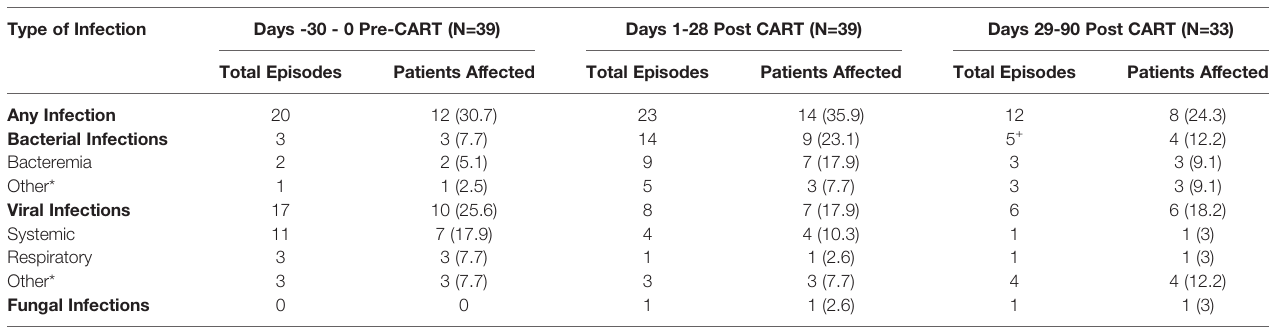
TABLE 3 | Infections pre- and post-CAR T cell